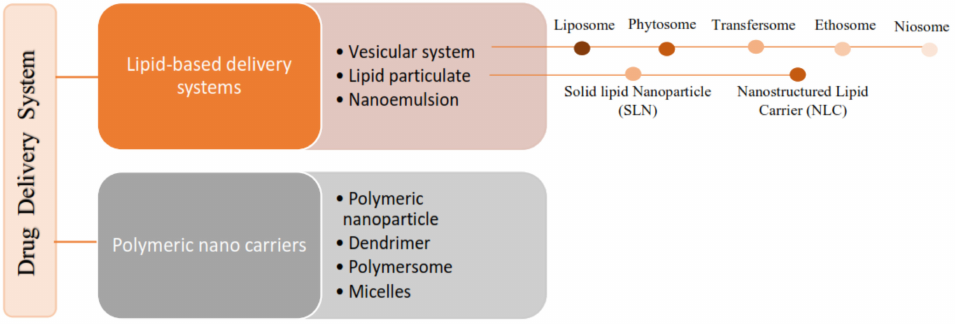
Figure 2. The nanotechnology-based delivery system for phytochemical constituents